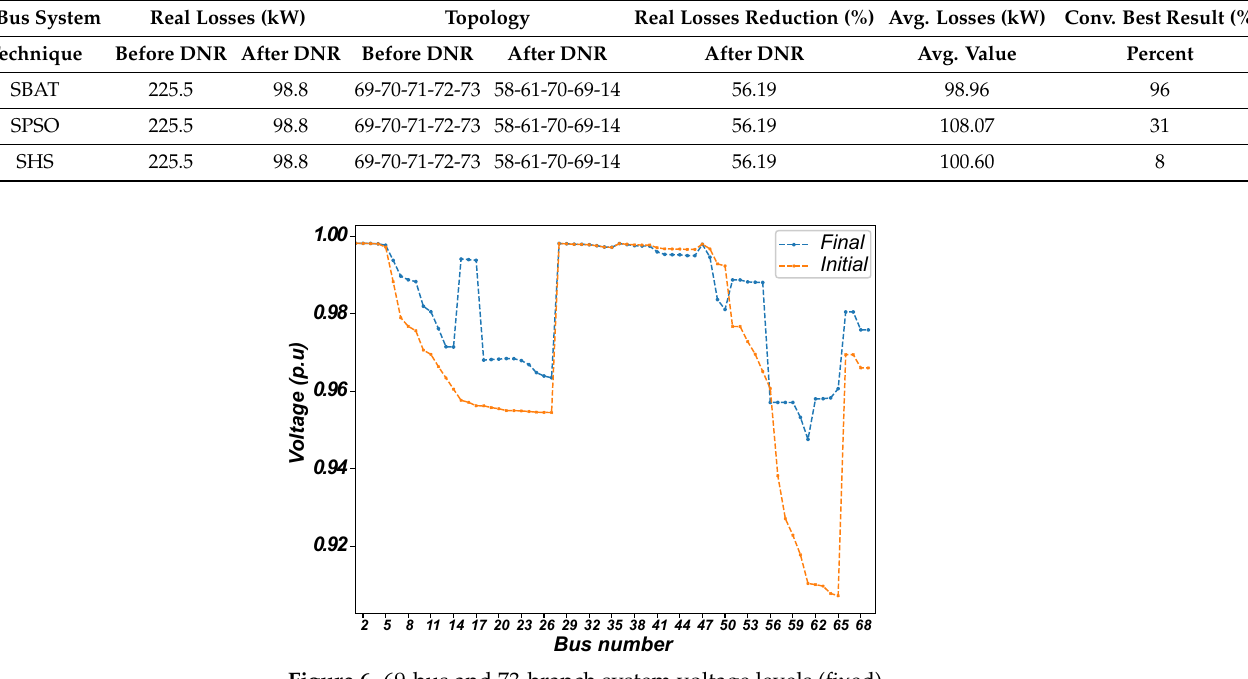
Figure 6. 69-bus and 73-branch system voltage levels